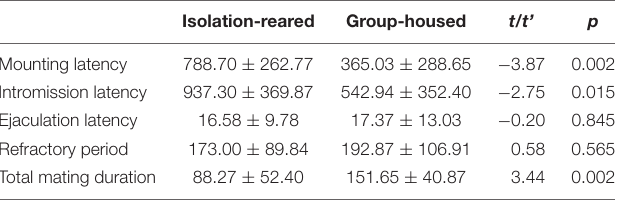
TABLE 3 | Heterosexual behavior of isolation-reared and group-housed mice.